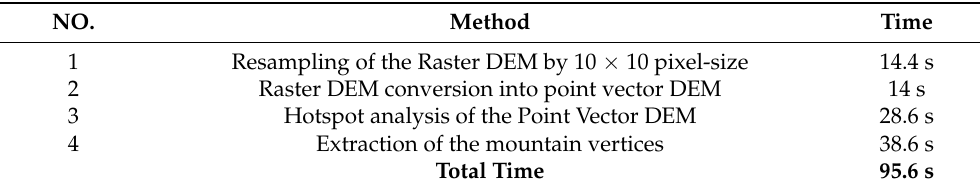
Table 23. The time consumed in extracting mountain vertices for the seventh dataset using our proposed approach.